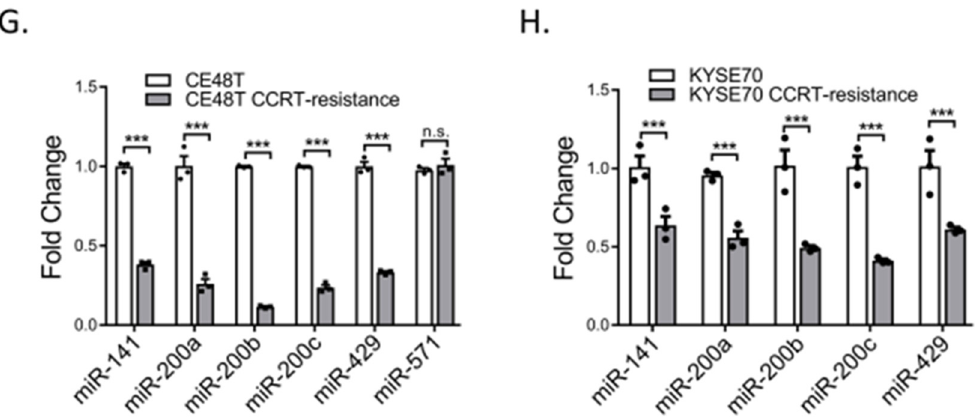
Figure 2. Acquired CCRT resistance cells exhibit the conversion of epithelium to mesenchyme and down-regulate miR-200 family expressions. ( A ) CCRT resistance ability correlated with the status of epithelial–mesenchymal conversion in three independent CE48T CCRT-resistance lines. Total cell lysates from CE48T control and three independent CCRT R cells as showed in Figure 1B were collected and examined by Western blot analysis using anti-E-cadherin and N-cadherin antibodies. β -actin was used as loading control. ( B ) Examination of E-cadherin and mesenchymal-related markers (N-cadherin, snail, slug) expressions. Total cell lysates of CE48T control and CCRT R cells were harvested and then subjected to Western blot analysis using the indicated antibodies. β -actin was used as loading control. ( C ) Total cell lysates of Kyse70 control and CCRT R cells were examined by Western blot analysis using the indicated antibodies as described in ( B ). ( D ) Immunofluorescence analysis of E-cadherin expression in CE48T and Kyse70 parental and CCRT resistance cells. E-cadherin expression was shown in green color and DNA staining in blue. Scale bar: 50 μ m. Compared to parental cells, the immunofluorescence intensity of E-cadherin expression was reduced and its subcellular location in the cell surface was impaired in CCRT resistant cells. ( E ) Identification of potential microRNAs by Human OneArray system (HOA 6.1). Total RNA from control and CE48T CCRT R cells were extracted and then subjected to microRNA microarray to identify differential miRNAs expressions in control and CE48T CCRT R cells. Red and green colors indicate high and low expression, respectively. ( F ) A list of downregulated miRNAs in CE48T CCRT R cells. Ratio means miRNAs expression of CE48T CCRT R cells normalized to control cells. The 12 selected miRNAs showed at least a 3-fold lower expression in CE48T CCRT R cells. * indicated miRNAs belong to miR-200 family. ( G , H ) Validation of miRNA targets expression in CE48T and Kyse70 CCRT R cells by qRT-PCR analysis, respectively. The relative expression levels of five miR-200 family members (miR-200a, miR-200b, miR-200c, miR-141, and miR-429) were examined in CE48T and Kyse70 CCRT R cells, respectively, and normalized to control cells. Relative fold-change of each selected miRNA was shown, compared to control cells marker as 1. miR-571 was not differentially expressed in control and CCRT R cells, and using as an experimental control. * p < 0.05, *** p < 0.001, n.s.: not significant.